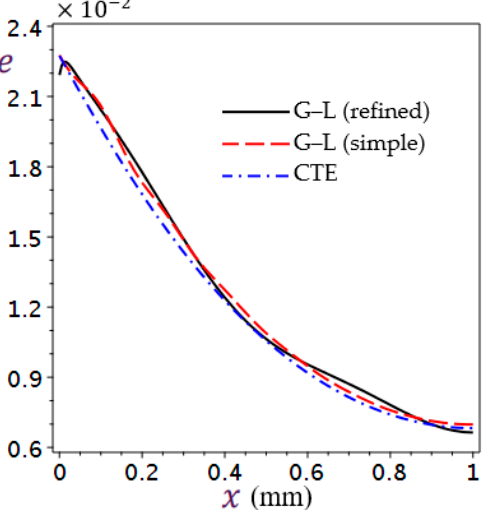
Figure 4. Two-dimensional plots of dilatation 𝑒 distributions in different theories of thermoelasticity.